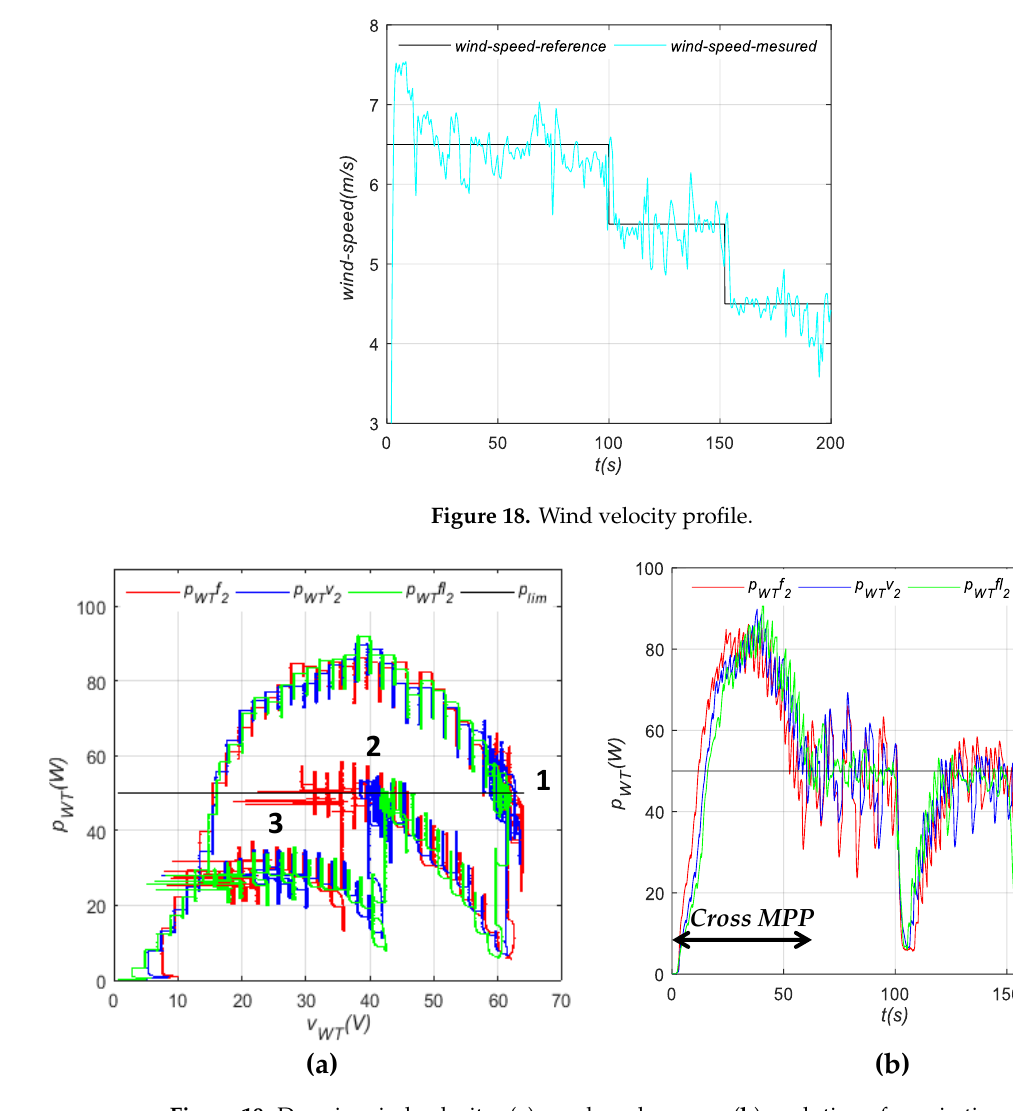
p based on v ; ( b ) evolution of WT WT